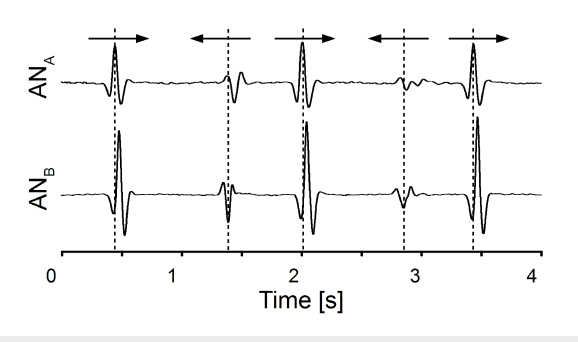
Figure 1: Responses of sensor platform I to a human finger that moved alongside the ALLC with a velocity of about 20 cm/s. Arrows indicate direction of finger motion. Responses of AN A (upper graph) and AN B (lower graph) are shown. Note that the responses were inverted if the direction of finger motion was